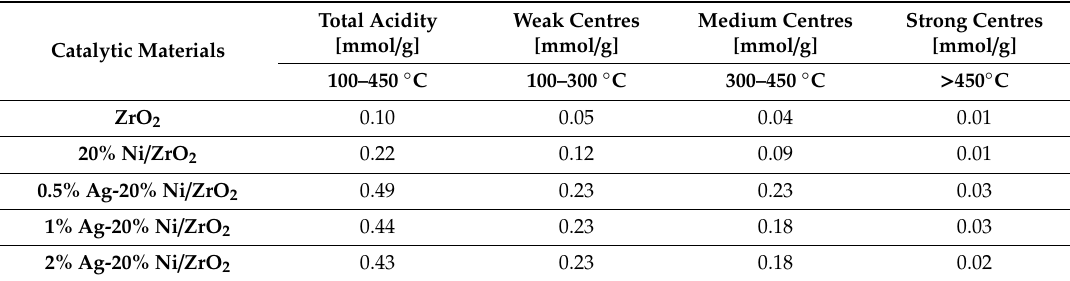
Table 5. The amount of NH 3 adsorbed on support surface (calcined in an air atmosphere for 4 h at 400 ◦ C), mono- and bimetallic reduced catalysts (reduction “in situ” at 500 ◦ C in a mixture of 5% H 2 -95% Ar mixture), calculated from the TPD-NH 3